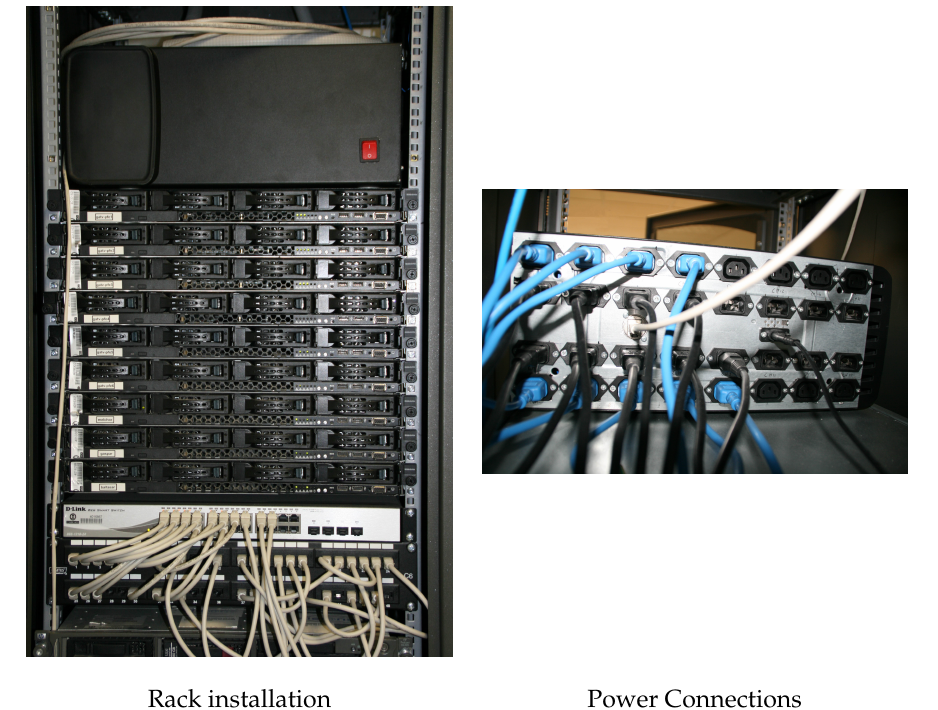
Figure 10. Prototype connection with the servers for energy usage